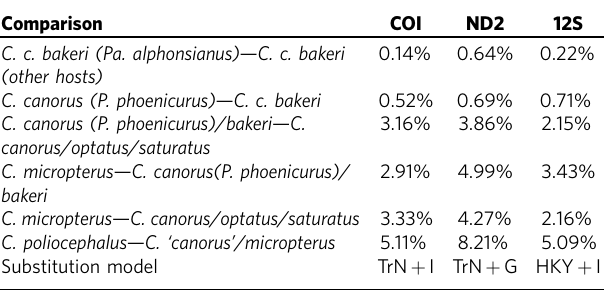
Table 1 | Pairwise genetic divergence between selected Cuculus lineages for three mitochondrial genes.